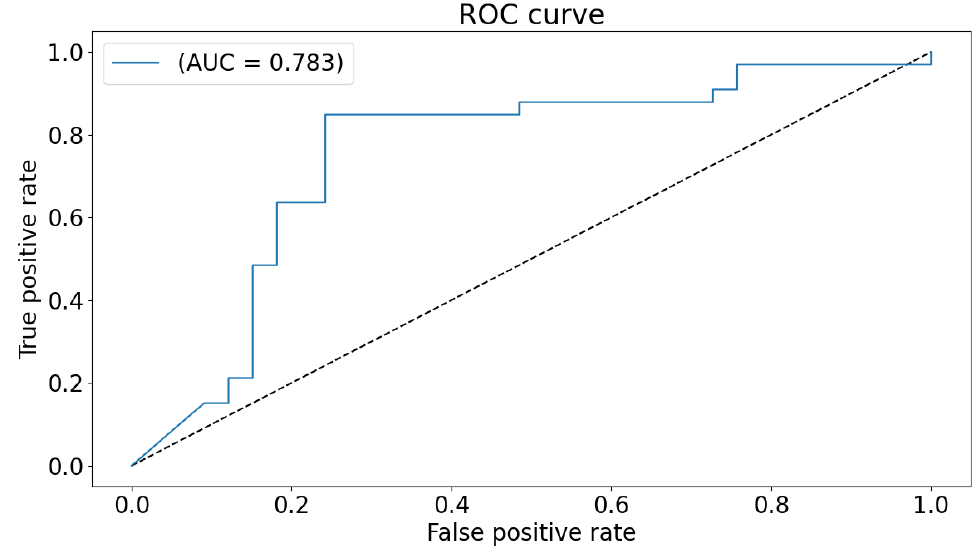
Figure 7. ROC curve and AUC for the global classifier.